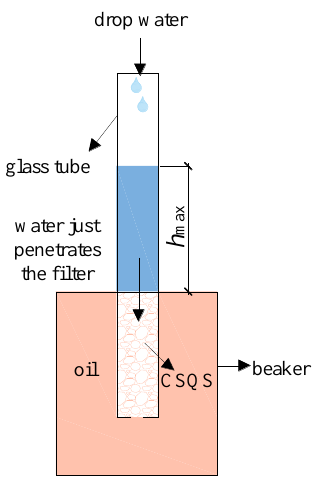
Figure 2. Diagram for water intrusion pressure device.